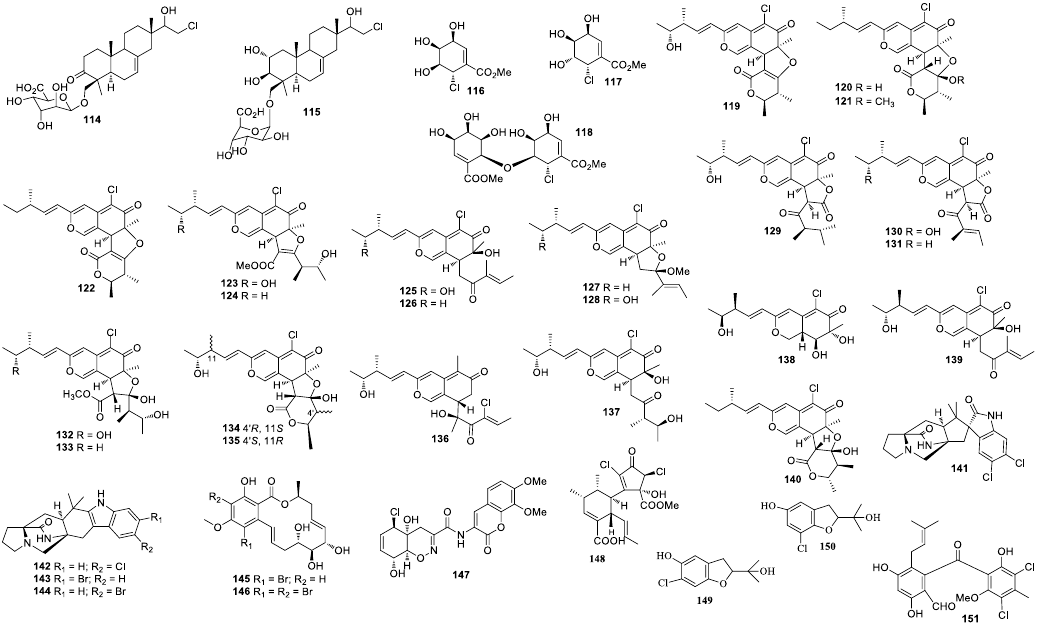
Figure 4. Structures of compounds 114 – 151.